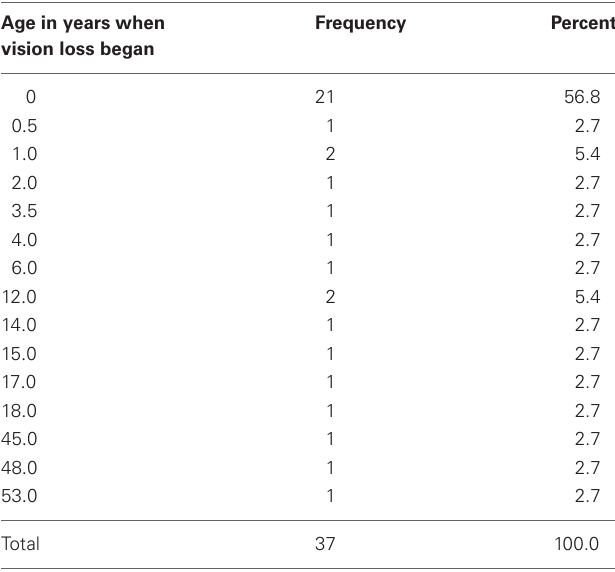
Table 2 | Summary of participants’ responses to survey question 5 “What is the main cause of your vision